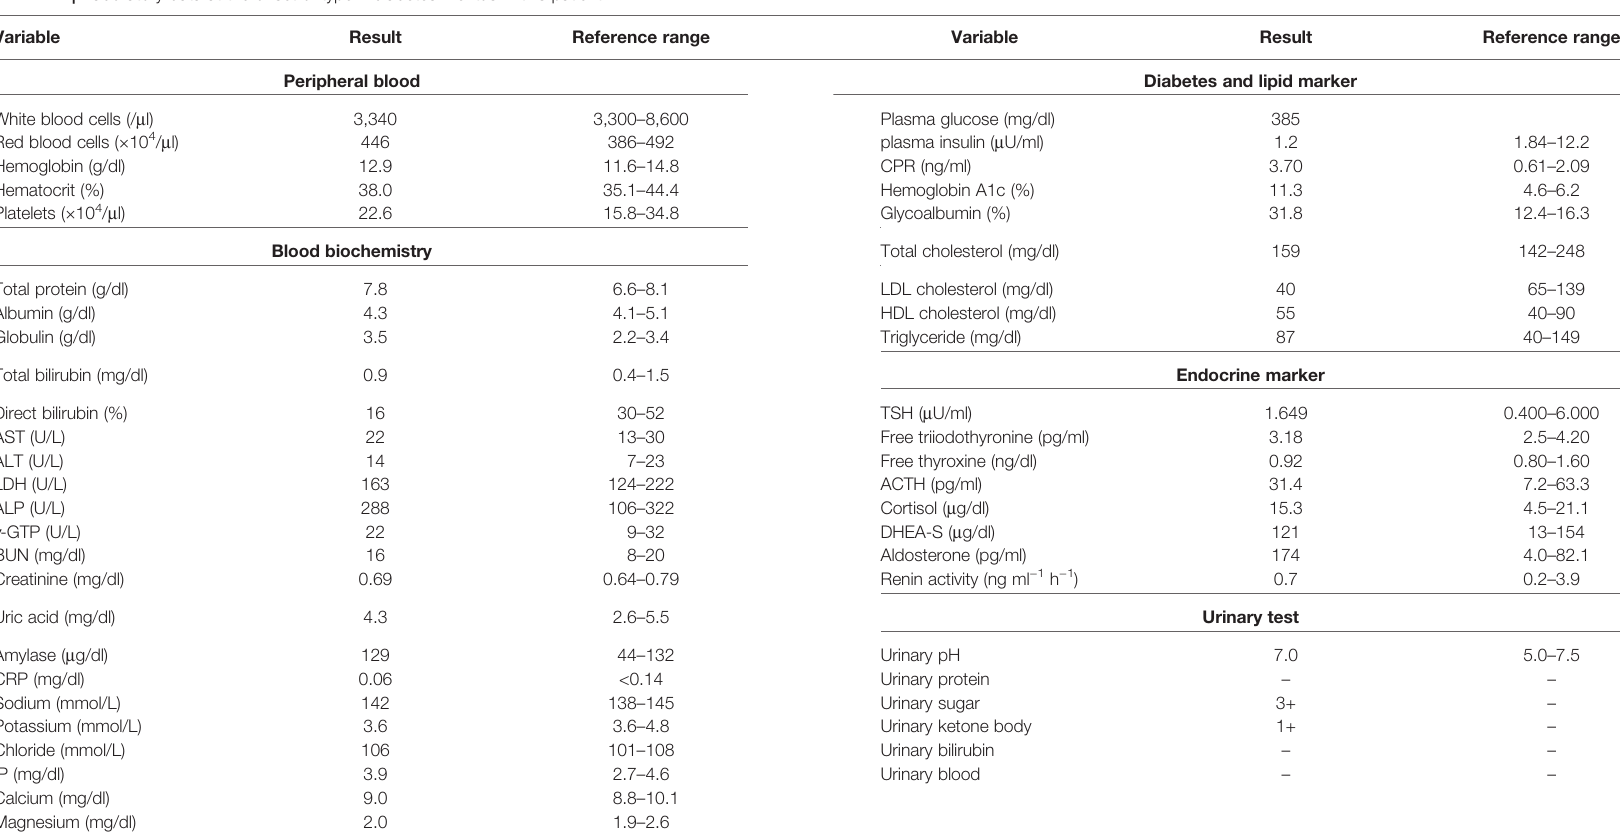
TABLE 1 | Laboratory data at the onset of type 1 diabetes mellitus in this